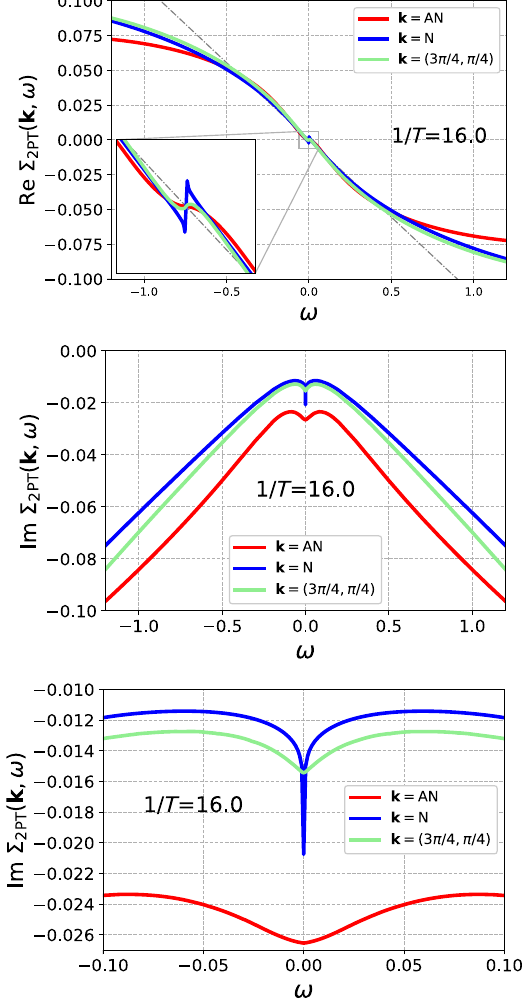
FIG. 29. Upper panels: real and imaginary parts of the self- energy from 2PTat 1 =T ¼ 16 for antinode (red), node (blue), and the generic point k ¼ ð 3 π = 4 ; π = 4 Þ (light green) on the real- frequency axis. The dotted-dashed line shows the respective result from a Fermi-liquid fit from the Matsubara axis.